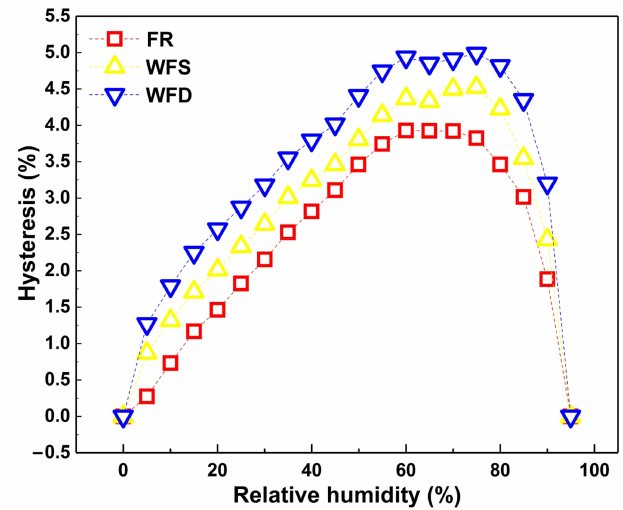
Figure 3. Sorption hysteresis of recent fir wood (FR), waterlogged archaeological fir wood from a sound region (WFS), and waterlogged archaeological fir wood from a decay region